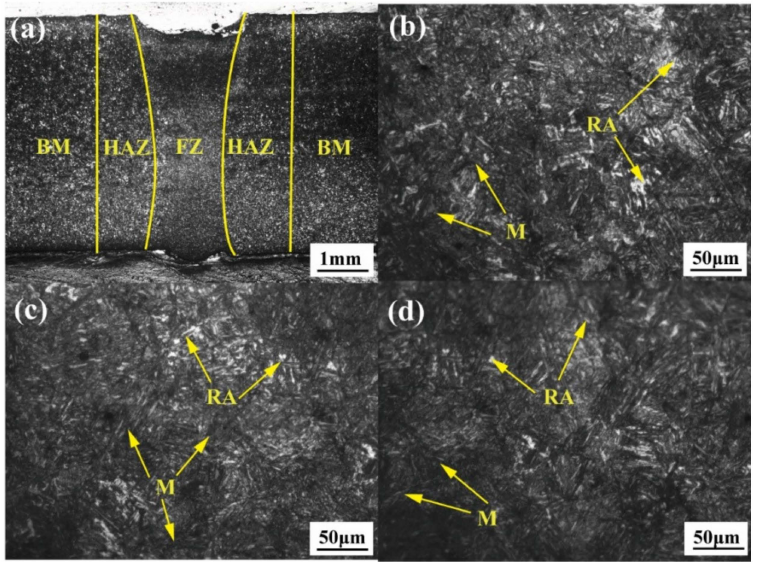
Figure 15. Microstructure of sample No.4 # after quenching: ( a ) macro morphology; ( b ) FZ; ( c ) HAZ; ( d )